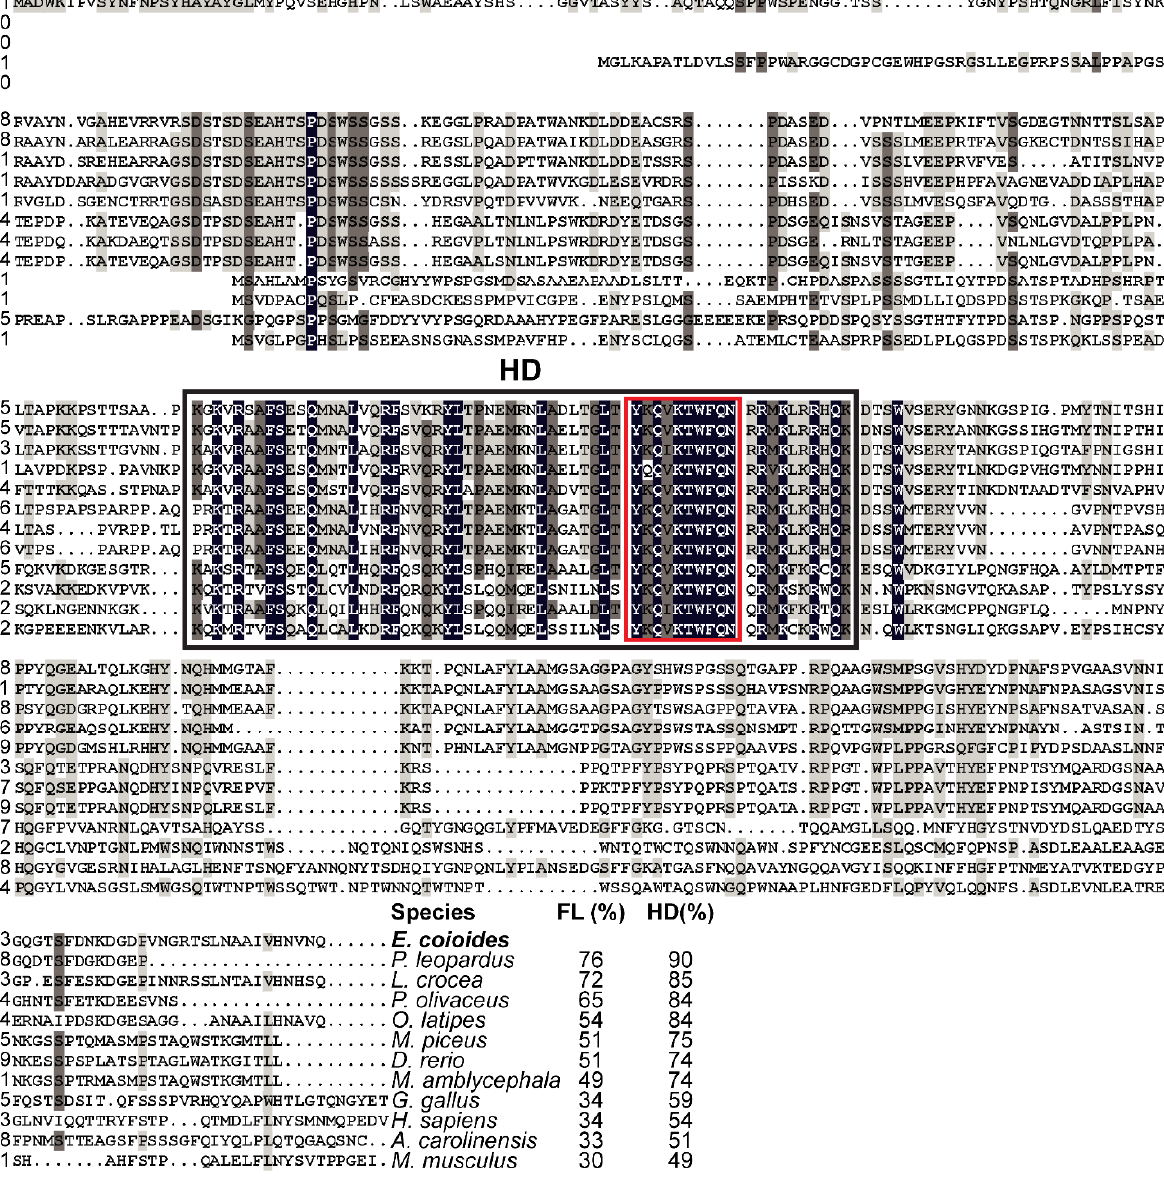
Figure 3. Multiple sequence alignment and comparison of EcNanog with the homologs from other vertebrates. Black shadow: 100% identity; Brown shadow: 75% ≤ identity < 100%; Light brown shadow: 50% ≤ identity < 75%. Large black box: HD domain; Red box: a nuclear localization motif of YKQVKTWFQN. The percent identity among EcNanog and its homologs in full-length (FL) and HD domain is displayed at the end of the alignment. The species name with a bold font indicates the EcNanog protein of orange-spotted grouper. GenBank accession numbers for Nanog are as follow: E. coioides , OK415852; Plectropomus leopardus , XP_042366645; L. crocea , XP_010739920; P. olivaceus , AGX84982; O. latipes , NP_001153902; M. piceus , ATP62010; D. rerio , NP_001091862; M. amblycephala , AMY98422; G. gallus , NP_001139614; H. sapiens , NP_079141; M. musculus , NP_082292; and Anolis carolinensis ,